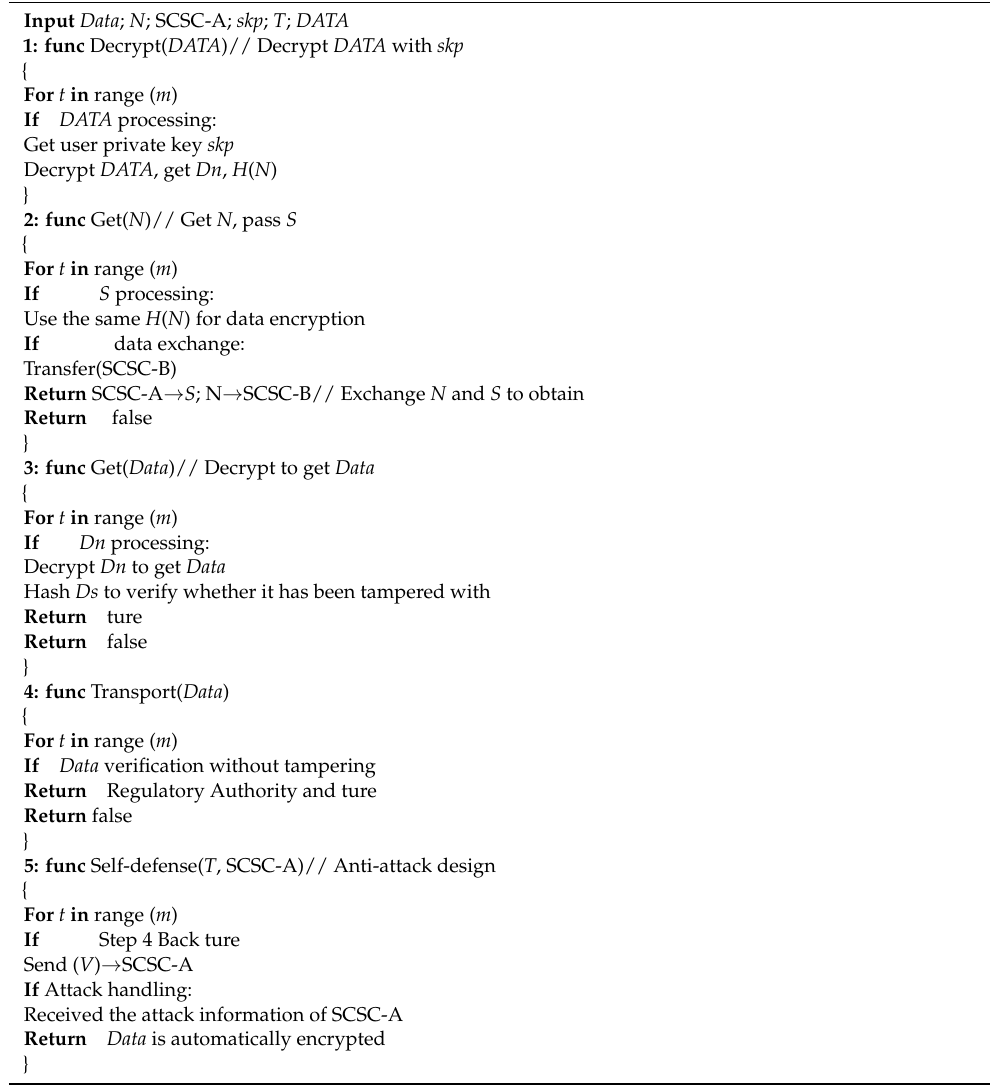
Algorithm A4 : Supervise cross-chain smart contract